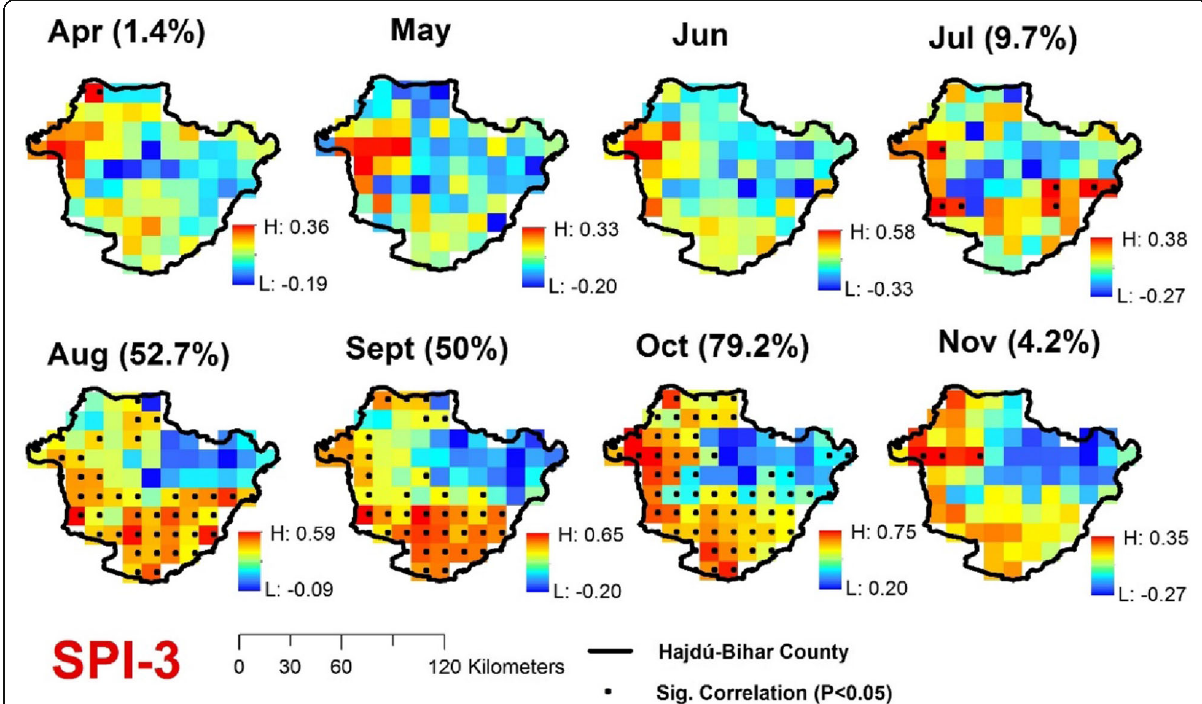
Fig. 7 Spatial-temporal correlation between monthly SPI-3-time scale and NDVI during the period of 1981 to 2010, the dots indicate a statistically significant correlation at 95% confidence level ( P <